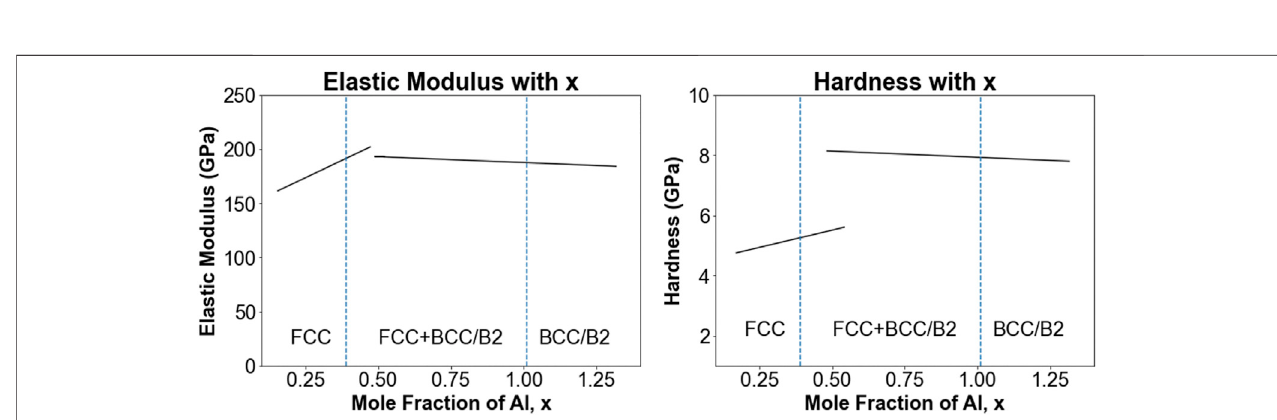
FIGURE6| EffectofAlcontentonthemechanicalpropertiesofAlxCoCrFeNi. (A) IncreasingAlcontentdoesnothaveasigni fi canteffectontheelasticmodulus, (B) Hardness of the alloy increases as the Al content is increased (adopted from Mu et al.). (adopted from (Li et al., 2018)).